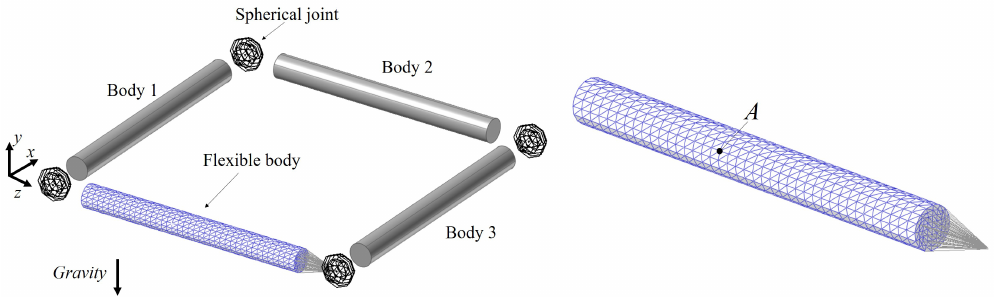
Figure 2. A quadruple pendulum with a flexible body (left) and the flexible cylinder with node A (right) to compare dynamics responses.